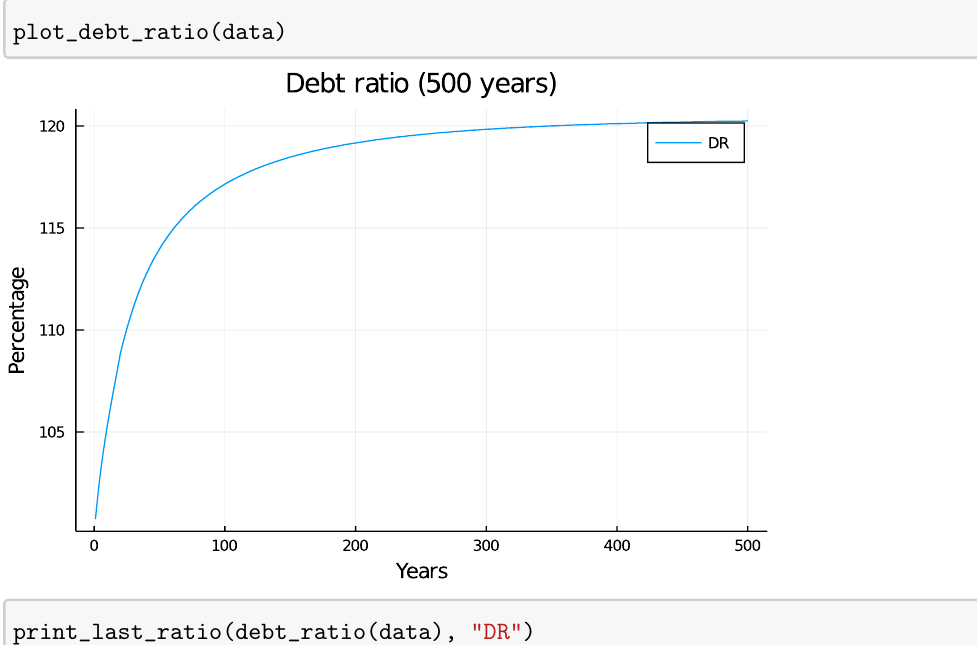
Figure 9. Growth ratio (LR = 15%, p = 0.8%, m = 20 years).